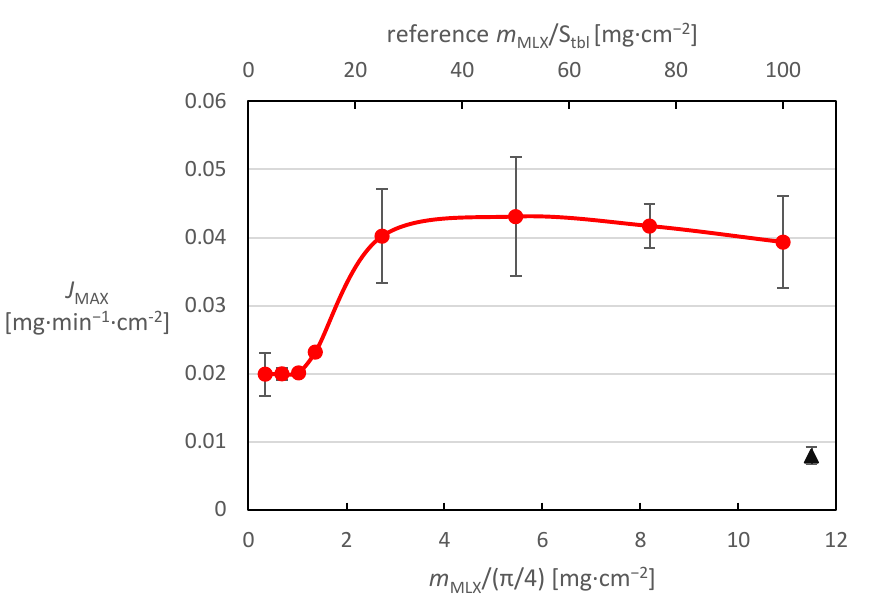
Figure 5. Maximum MX release flux depending on carrier surface coverage by MX (5 drops ■ , 10 drops ■ , 15 drops ■ , 20 drops ■ , 40 drops ■ , 80 drops ■ , 120 drops ■ , 160 drops ■ ) compared to the MX release flux from reference 100% MX tablet surface ( ▲ ).